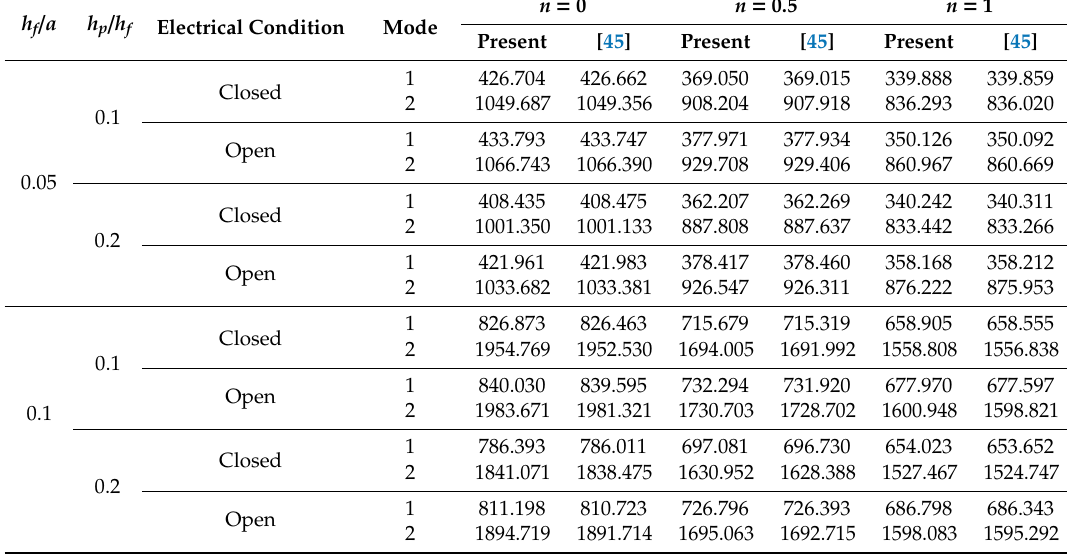
Table 3. The lowest two natural frequencies (Hz) of a SSSS PFGP with open and closed circuits.